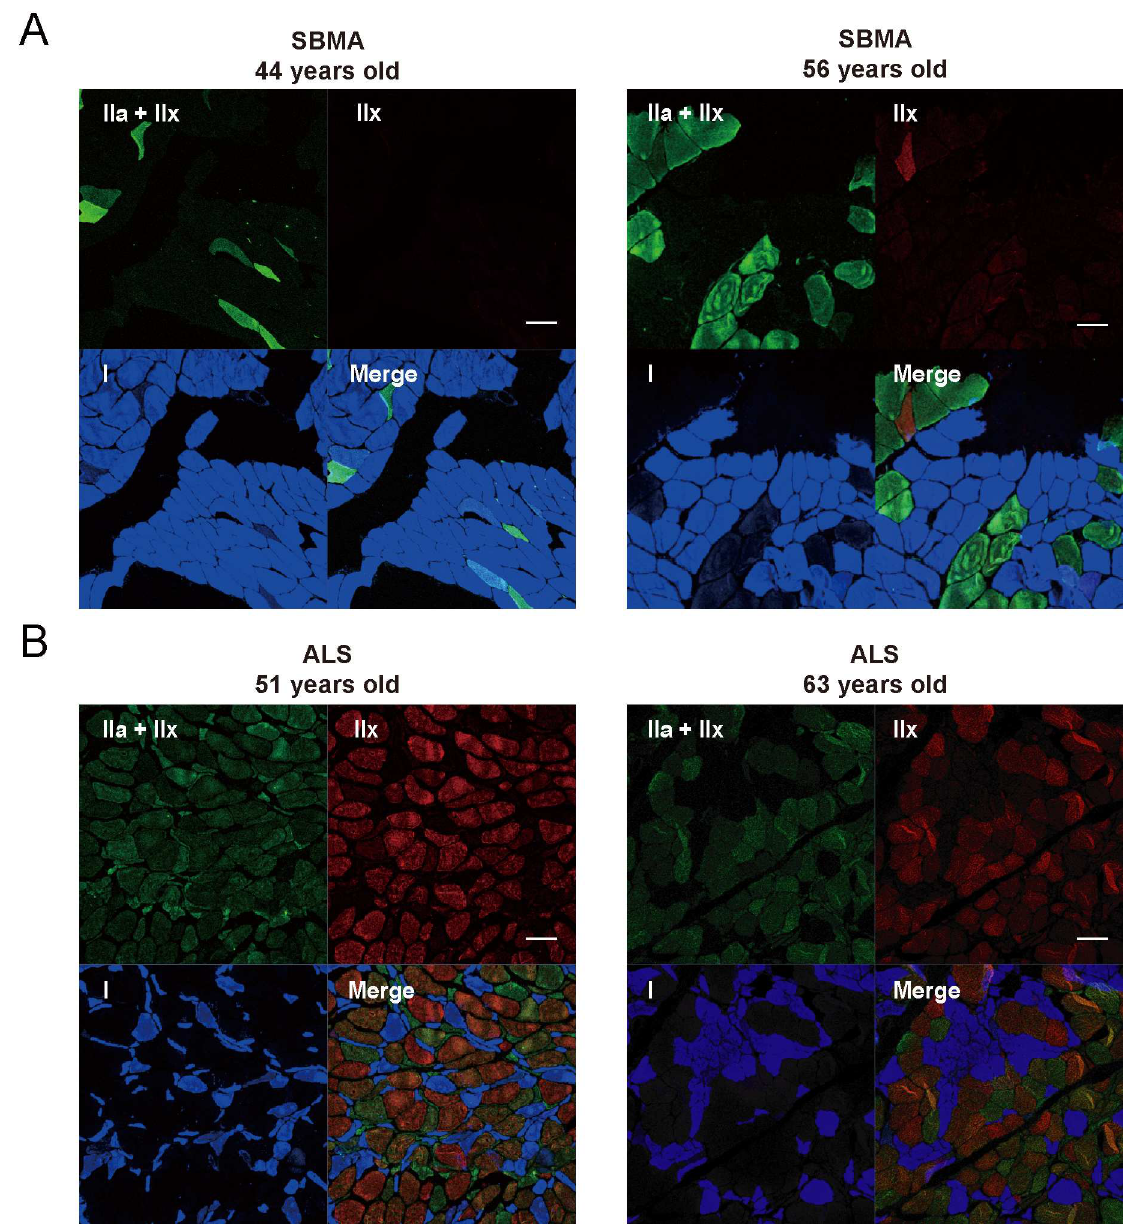
Fig 4. Disease-specific fiber type alterations in SBMA and ALS. (A, B) Representative images of anti-MHCimmunostaining in the biceps muscles of subjects with SBMA (A, n = 2) and ALS (B, n = 2). Type I (blue), type IIa (strong green), and type IIx (strong red and intermediate green) fibers are shown in single- and merged-channelimages of serial cross-sections of a humanbicep incubatedwith an antibody cocktail (BAF-8, SC-71, and 6H1). Type IIx fibers were substantially decreased in SBMA compared with ALS, whereastype I fibers were atrophied in ALS comparedwith SBMA. Scale bar, 100 μ m. SBMA, spinal and bulbar muscular atrophy; ALS, amyotrophic lateral sclerosis;MHC, myosin heavy